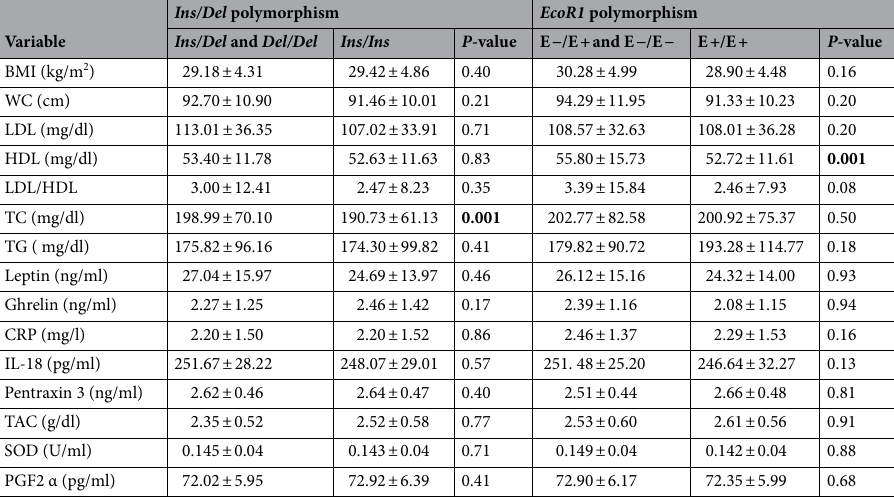
Table 2. Assessment of the associations of ApoB Ins/Del and EcoR1 polymorphisms with cardio metabolic parameters. P -value*: Independent T-test models. BMI: Body mass index, WC: waist circumference, LDL: Low density lipoprotein, HDL: High density lipoprotein, LDL/HDL: Low density lipoprotein / High density lipoprotein, TC: Total cholesterol, TG: Triglyceride, CRP: C-reactive protein, IL-18: Interleukin 18, PTX- 3: Pentraxin-3, TAC: Total antioxidant capacity, SOD: super oxide dismutase and 8-iso-PGF2α: 8-iso- Prostaglandin F2α. Bold indicate P -values lower than 0.05.